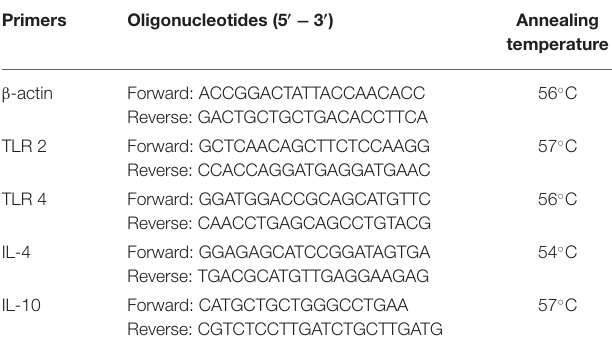
TABLE 3 | Primers used in qRT-PCR for quantification of TLRs and cytokines mRNA expression.